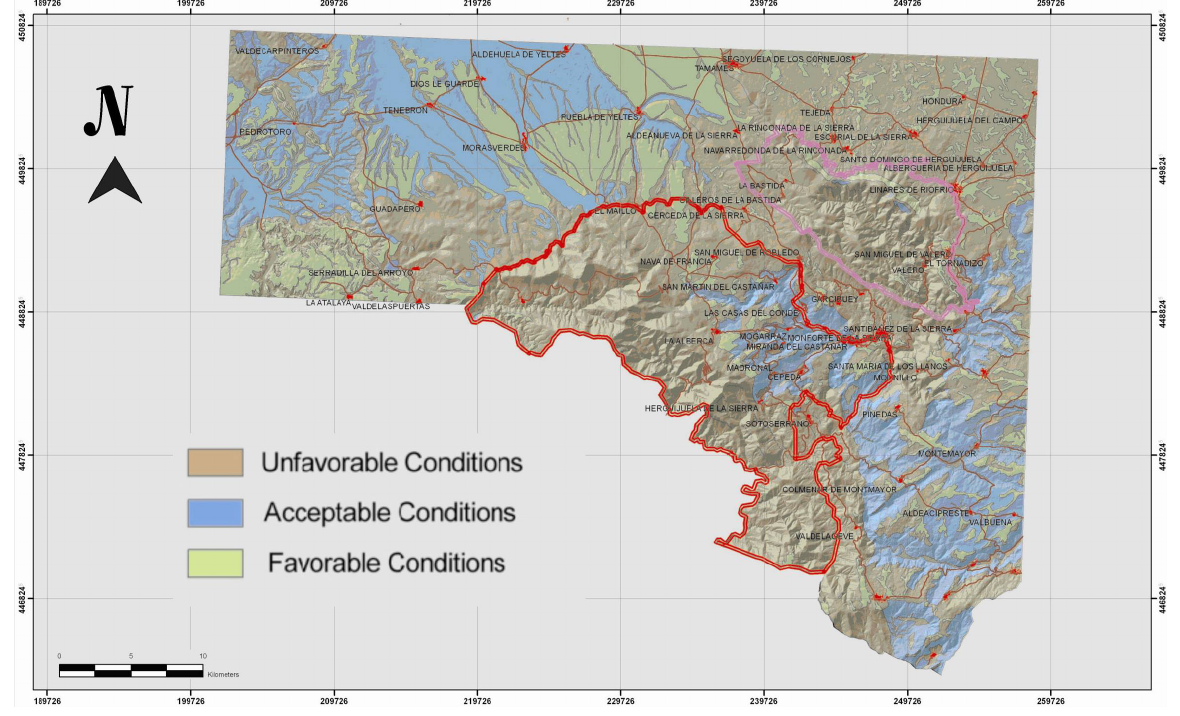
Figure 6. ( a ) Natural hazard mapping and ( b ) geotechnical hazard